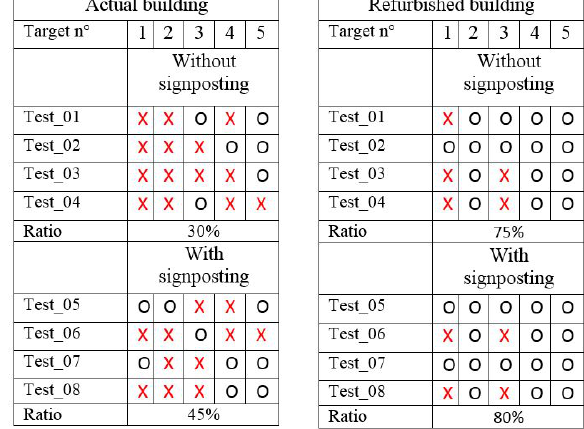
Figure 13: Orientation tests